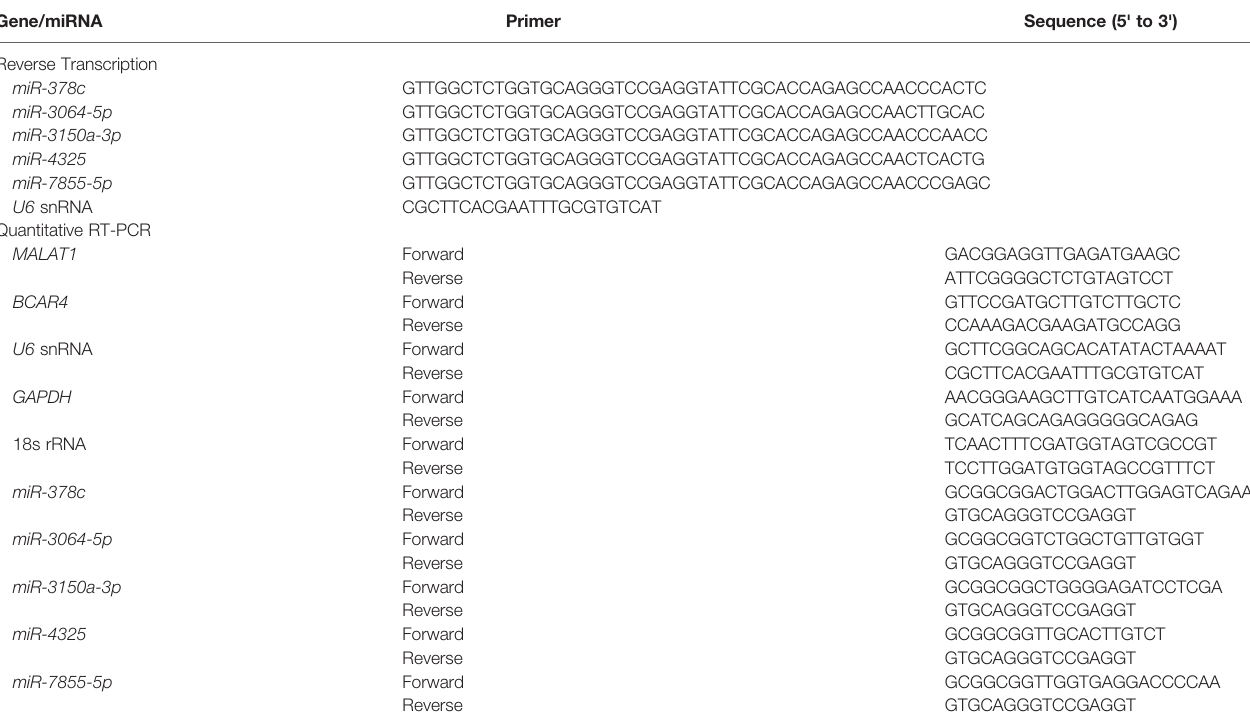
TABLE 1 | The primers for reverse transcription and quantitative